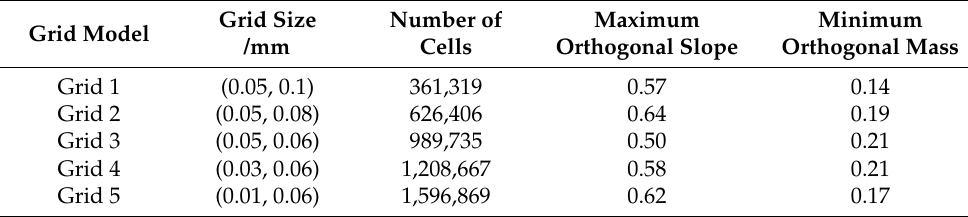
Table 3. Information on the grid schemes.